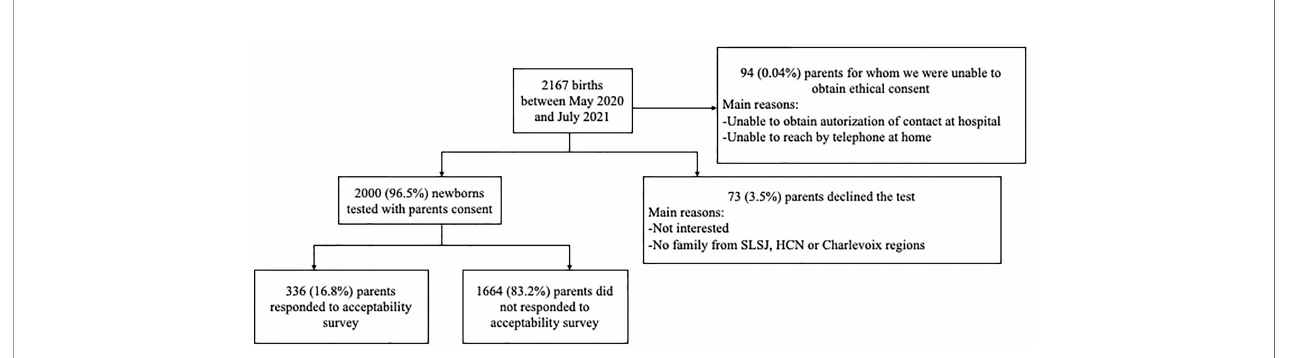
FIGURE 1 | Flowchart of newborn screening for VDDR1A.